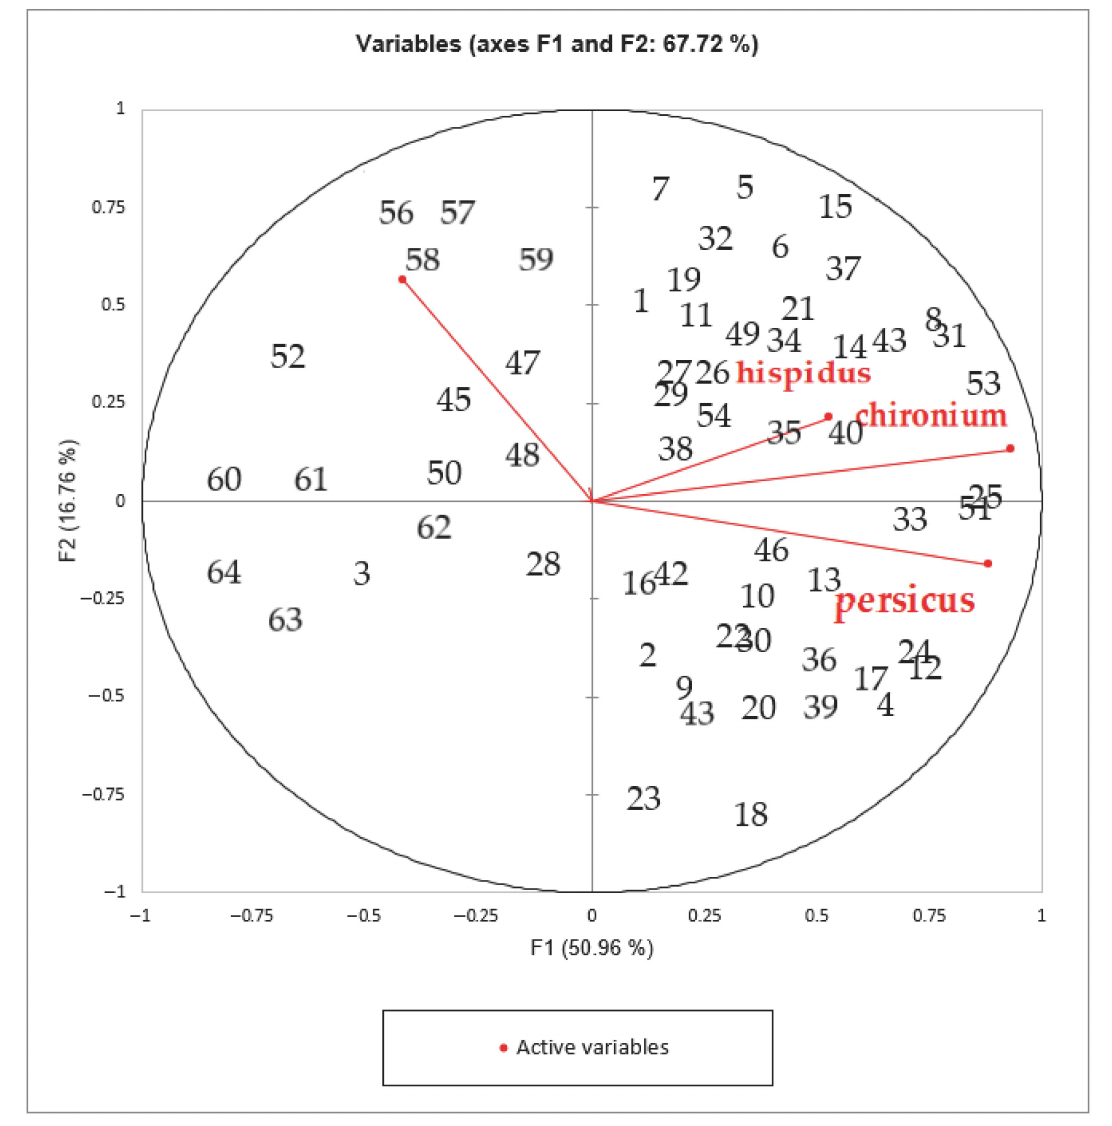
Figure 3. Biplot (PCA) of the composition of the essential oils of the examined Opopanax